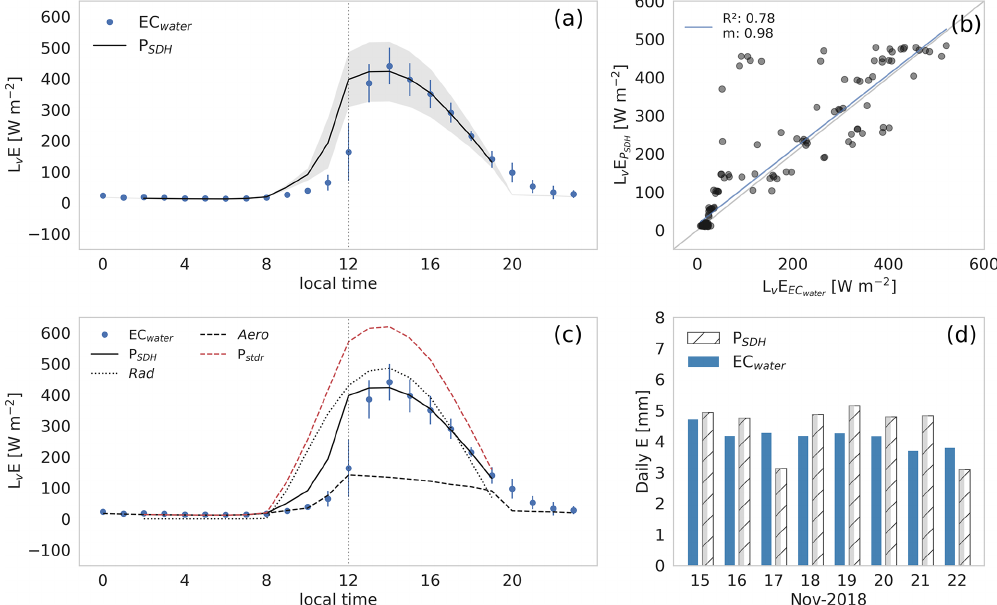
Figure 4. (a) Daily average and standard deviation of L v E observed by EC water and calculated by the P SDH equation during the E-DATA period. (b) Orthogonal regression between L v E measured by the EC water and those estimated through P SDH . (c) Diurnal cycle of L v E observed by EC water , calculated by P SDH , standard Penman ( P stdr ), and the aerodynamic (Aero) and radiative (Rad) contribution. (d) Daily evaporation (mm) measured by the EC system and estimated through P SDH . The vertical dotted line in (a) and (c) indicates the wind regime